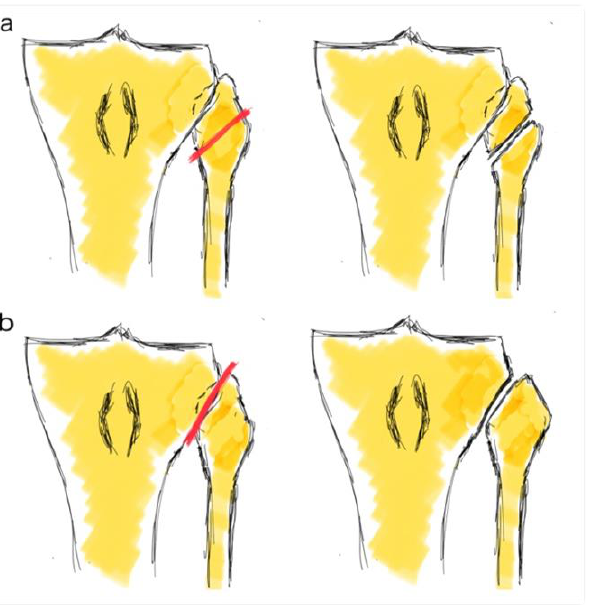
Figure 1. Fibular head osteotomy ( a ) and tibiofibular joint dislocation ( b ). Figure reproduced from [9].